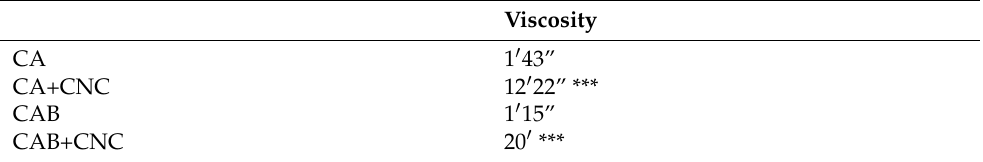
Table 2. Viscosity values for the formulated coatings. CA: Commercial acrylic waterborne